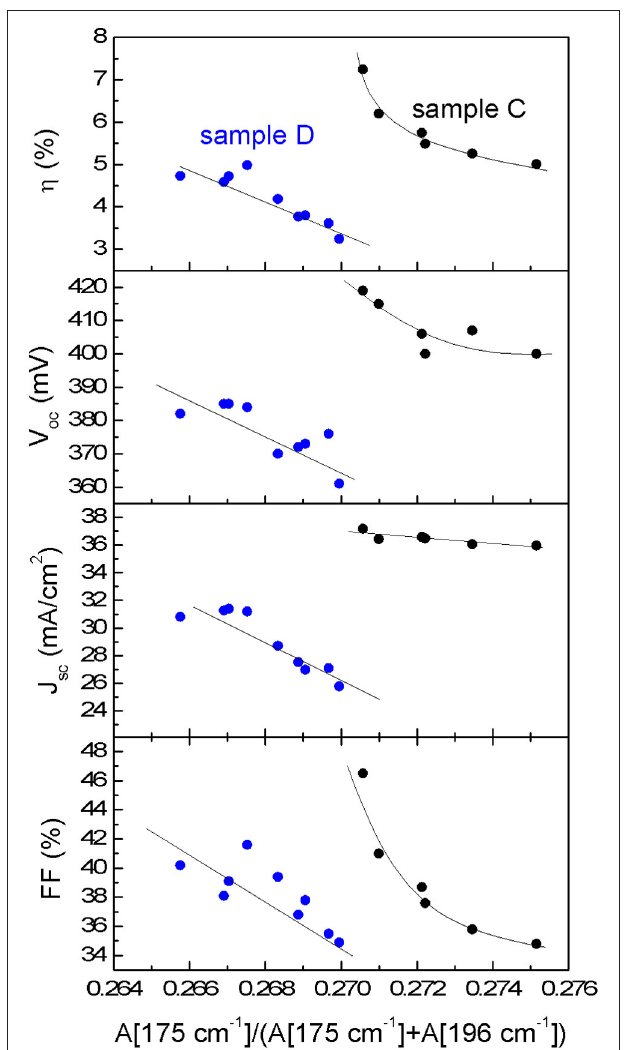
FIGURE 5 | Correlation of the photovoltaic parameters of devices C and D with the A[175 cm − 1 ]/(A[175 cm − 1 ] + A[196 cm − 1 ]) Raman intensity